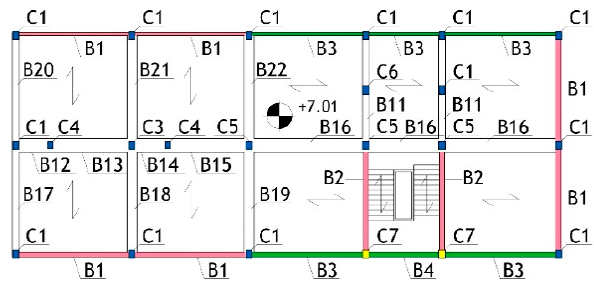
Figure 14. Localization of the interventions—first storey.